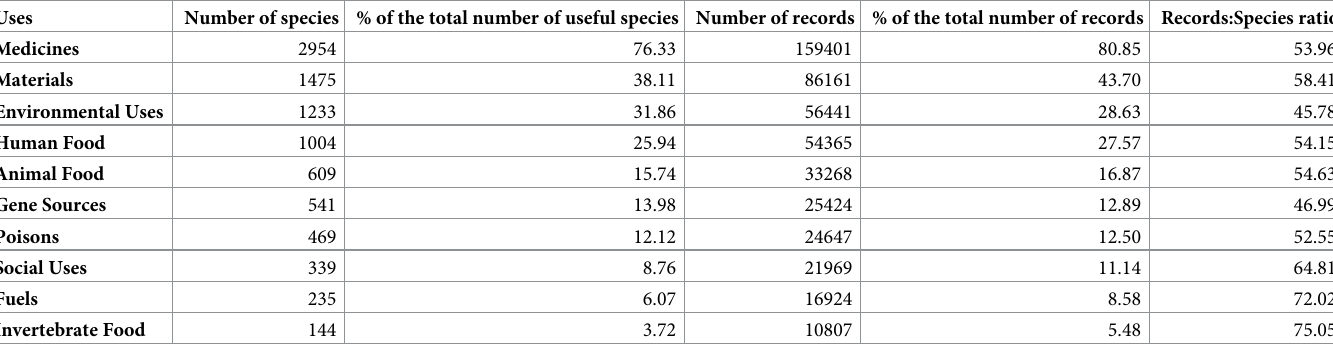
Table 2. Useful plants and their